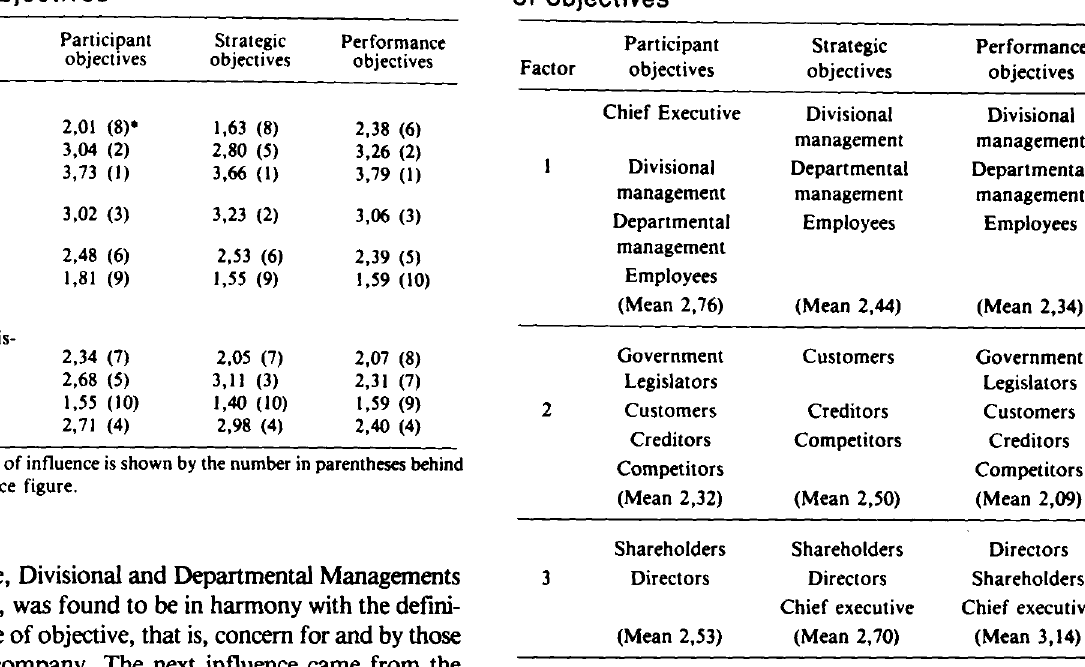
Table 6 Comparative mean influences of individual interest groups on the formulation of the three classes of objectives